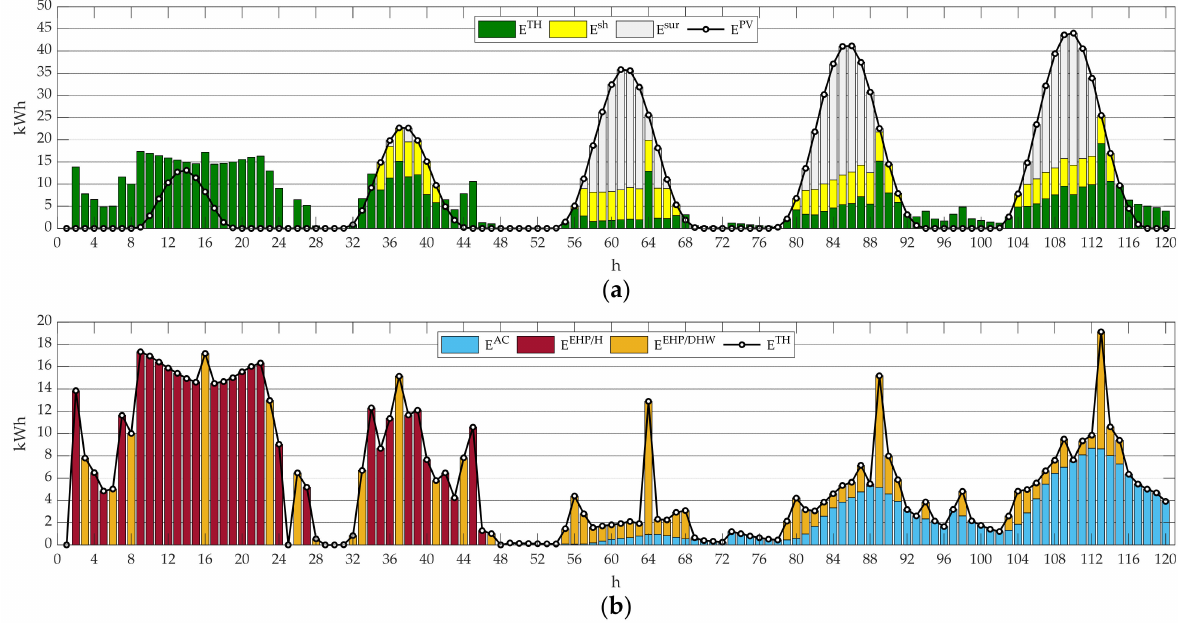
Figure 7. Simulation results: ( a ) distribution of PV generation among the supply of communal loads, shared, and surplus electricity; ( b ) dispatch of thermal communal